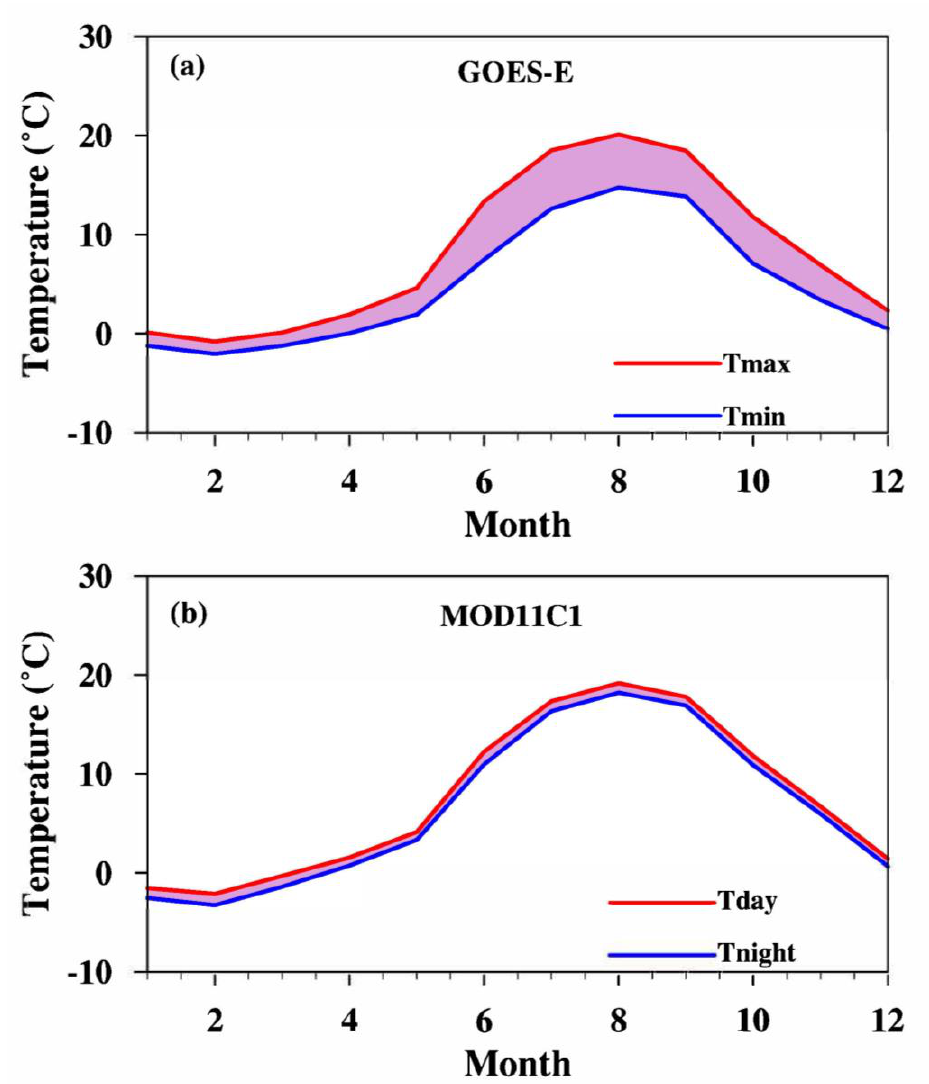
Figure 9. ( a ) Annual change of the average maximum/minimum LST (DTR) over Lake Huron from GOES-E during 2004–2009; ( b ) annual change of the average Day/Night LST over Lake Huron from MOD11C1 (Terra) during 2004–2009.